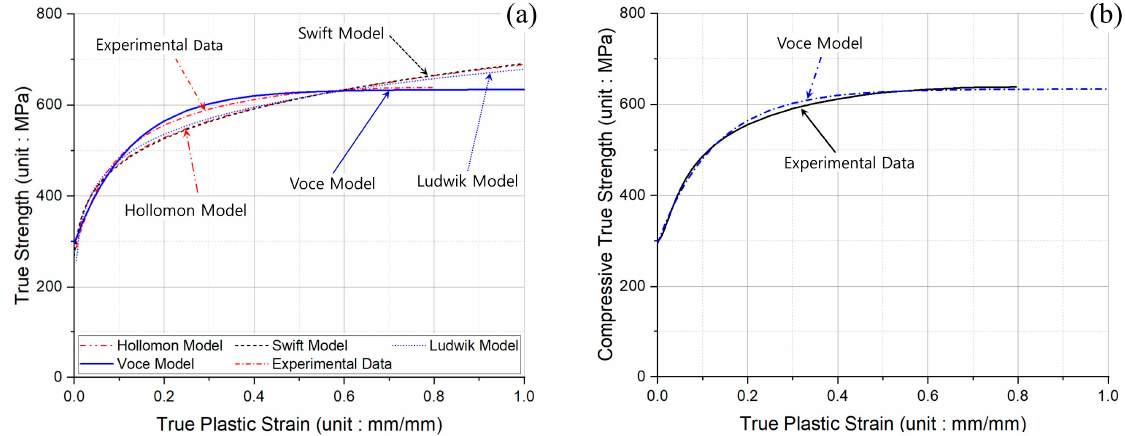
Figure 6. Comparison of flow stress curves using experimental data from uniaxial compression tests: ( a ) true plastic stress-strain curves using various flow stress models; ( b ) true plastic stress-strain curves between Voce model and experimental data. Table 4. Prediction and comparison on true stress-strain curve using various flow stress models. Flow Stress Model